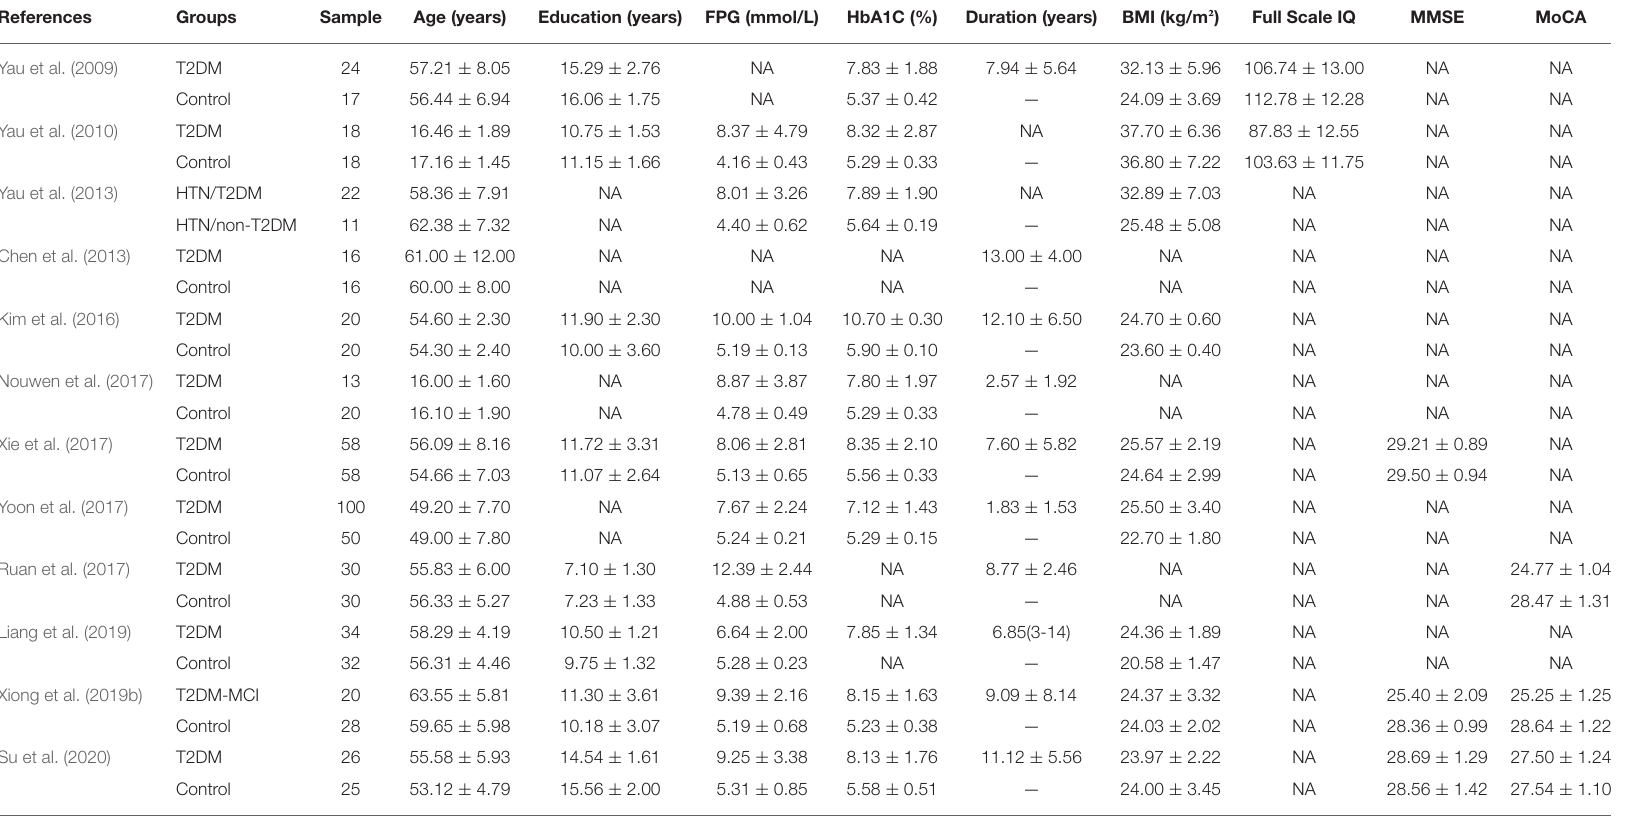
TABLE 1 | Study and subject information of the studies included in the current